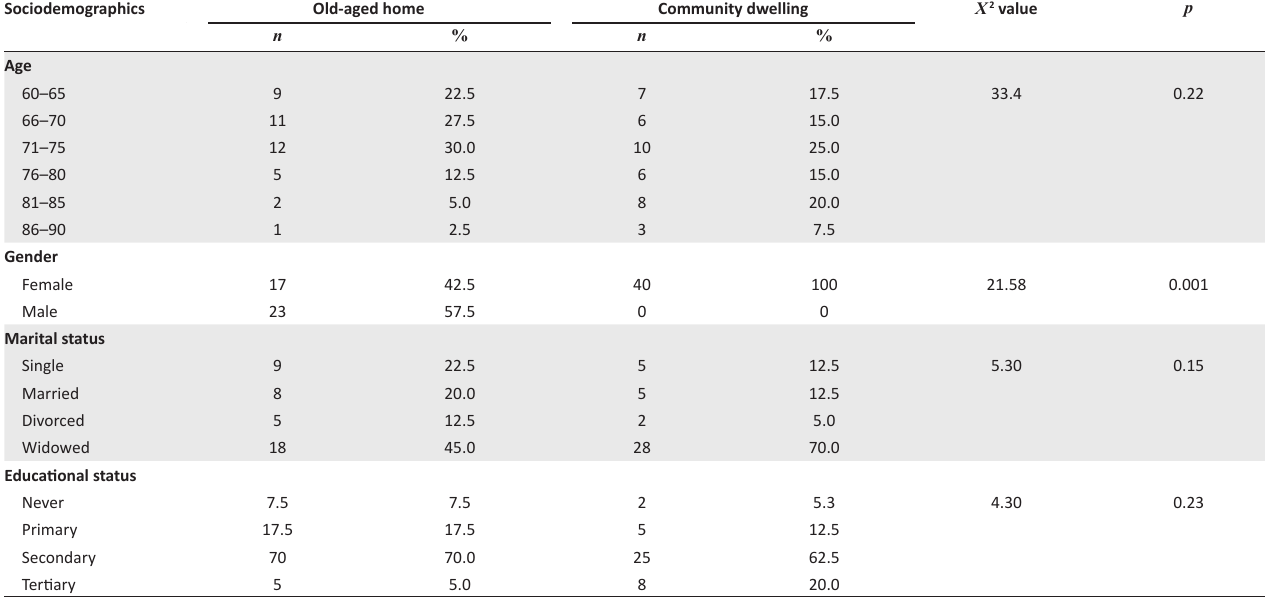
TABLE 1: Distribution of sociodemographics of old age home and community dwellers. Sociodemographics